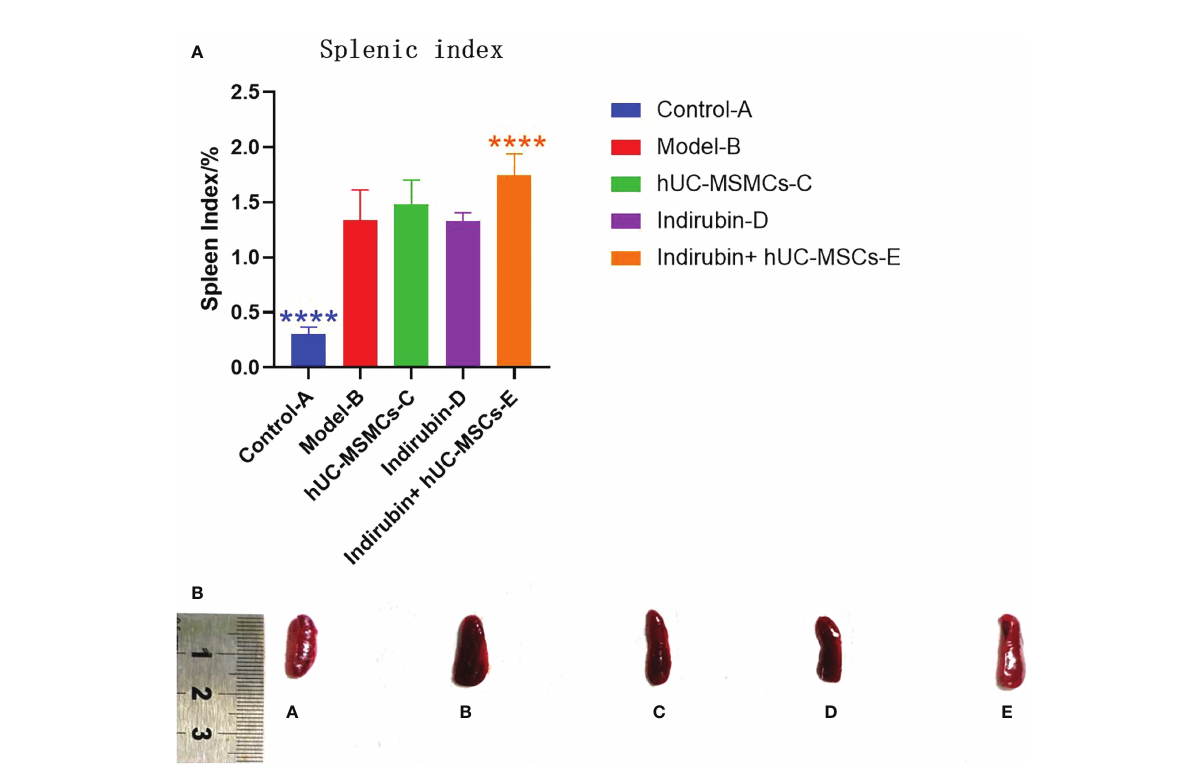
FIGURE 4 The spleen index (spleen mass/body mass) was calculated on day 7 in each group. (A) Spleen index of mice in each group (one-way ANOVA/ Dunnett ’ s test). (B) Comparison of spleen size. ****P < 0.0001, compared with model B. A, Control-A; B, Model-B; C, hUC-MSMCs-C; D, Indirubin-D; E, Indirubin+hUC-MSCs-E.